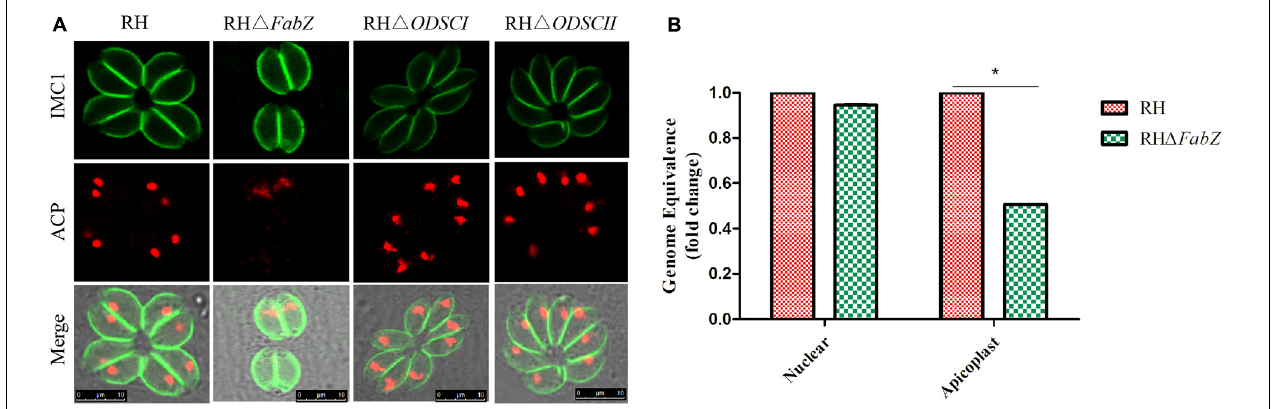
FIGURE 4 | The effect of gene knockout on the apicoplast of T. gondii RH strain. (A) Immunofluorescence localization of the anti-acyl carrier protein (ACP) in the apicoplast using an apicoplast-specific antibody. The ACP specific fluorescence was hardly detected in the apicoplast of tachyzoites of (cid:49) FabZ , but was clearly visible in the tachyzoites of (cid:49) ODSCI , (cid:49) ODSCII, and WT strains. Scale bars, 10 µ m. (B) Quantitative PCR was performed to detect apicoplast and nuclear gene in (cid:49) FabZ and WT RH strains. The expression of the apicoplast gene in (cid:49) FabZ strain was significantly decreased. The data are presented as means ± SEMs ( n = 3 in triplicates). * P < 0.05; ns, non-significant by Student’s t -test and Gehan-Breslow-Wilcoxon